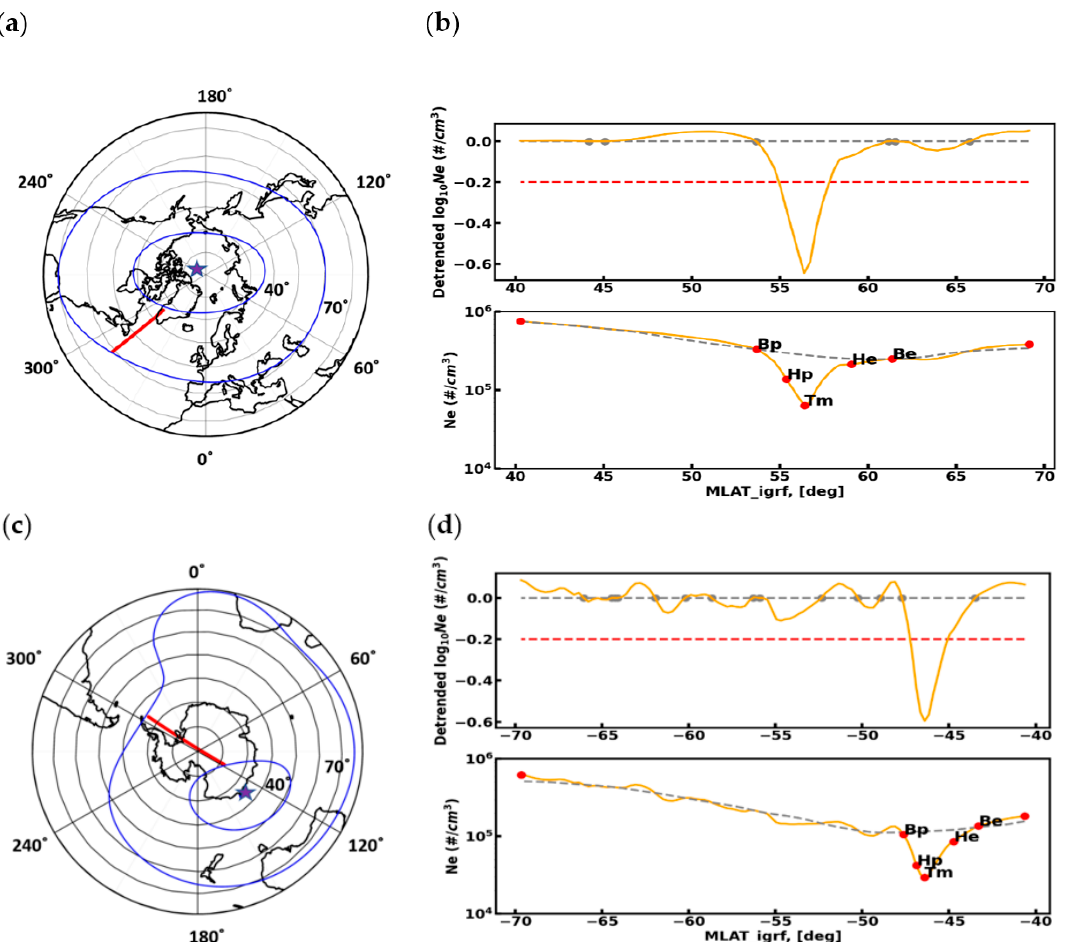
Figure 2. Examples of the GRACE trajectory over the northern ( a ) and southern ( c ) hemispheres on 14 April 2002 between 40° and 70° magnetic latitudes. Concentric circles are plotted in 10° intervals. The blue lines correspond to magnetic latitudes 40° and 70°. The red line is the footprint of the satellite path. The magnetic pole is marked with a star. Corresponding Ne profiles with detected trough minimum position and trough characteristic points for the northern ( b ) and southern ( d ) hemispheres (see below plots). Detrended logs of Ne are represented in upper plots for the northern ( b ) and southern ( d ) hemispheres. The gray dashed line represents the Ne running average. The yellow line is the Ne profile, and the red dashed line shows the threshold for trough detection.